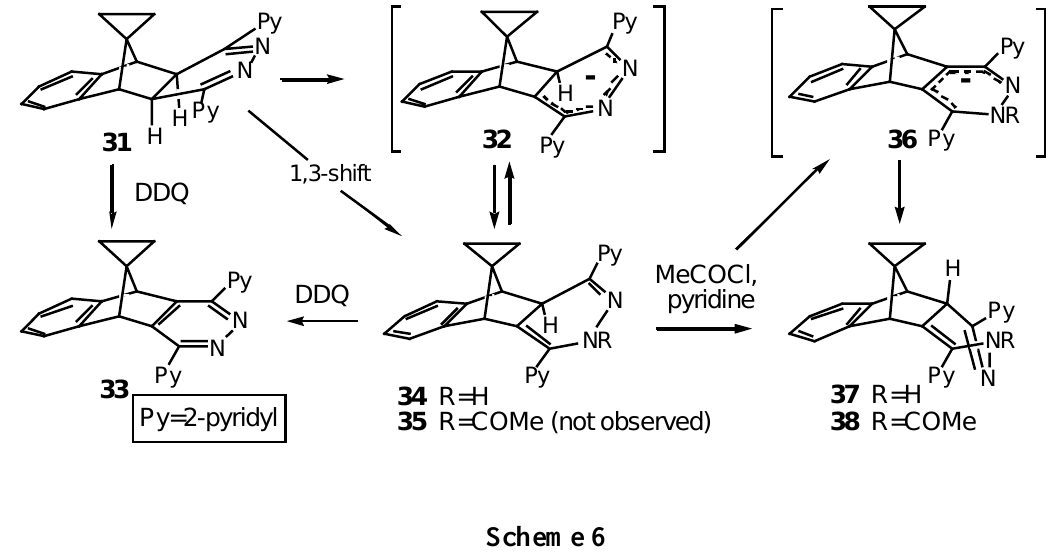
) of N -acetyl 1,4-dihydropyridazine 3